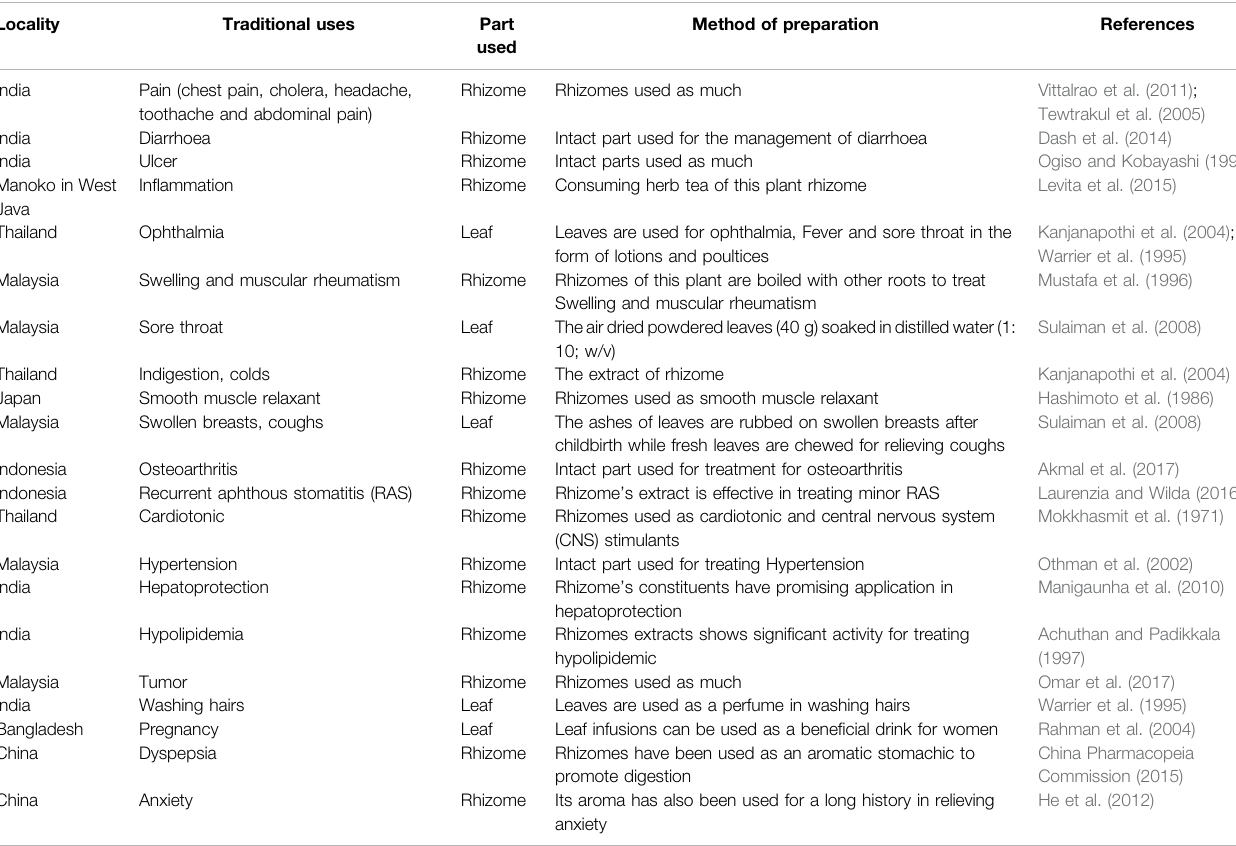
TABLE 1 | Ethnomedicinal uses of K. galanga. Locality